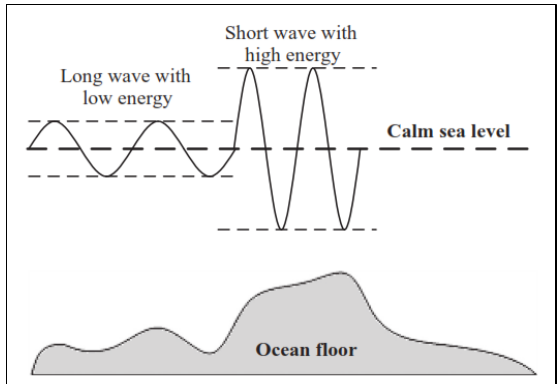
Figure 1. Relationship between the wave height and the seabed.